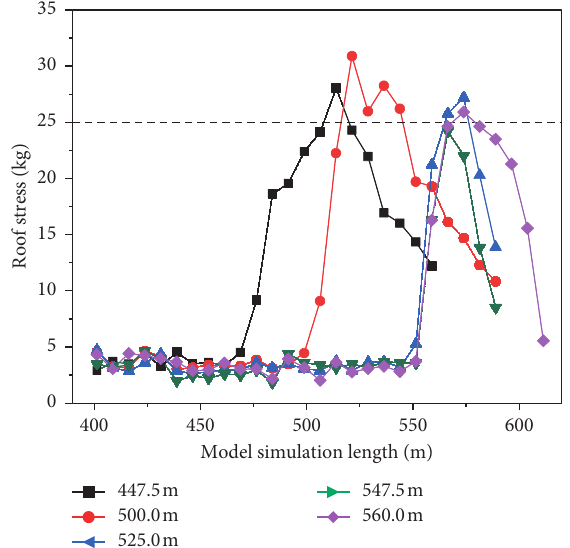
Figure 6: The stress characteristics of the roof at different ad- vancing